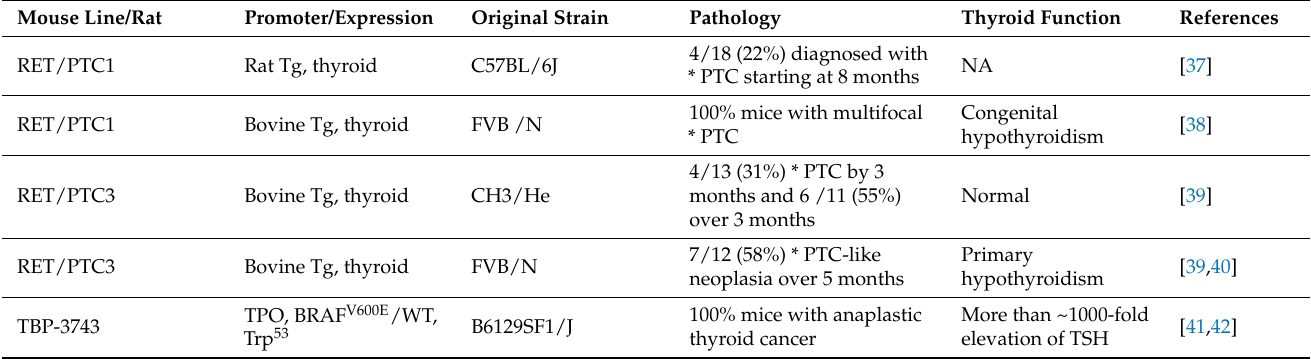
Table 2. Experimental Models of thyroid oncogenesis in transgenic